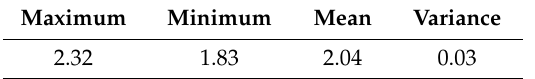
Table 6. Statistical parameters for final gravimetric water contents of cracked soil